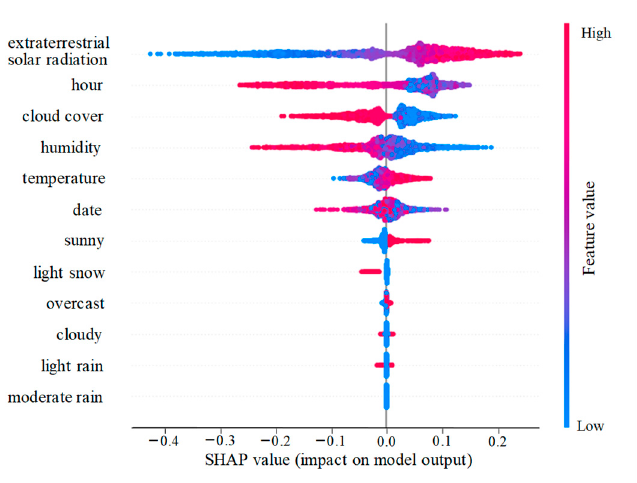
Figure 9. Density sca tt er plot of the SHAP analysis results.